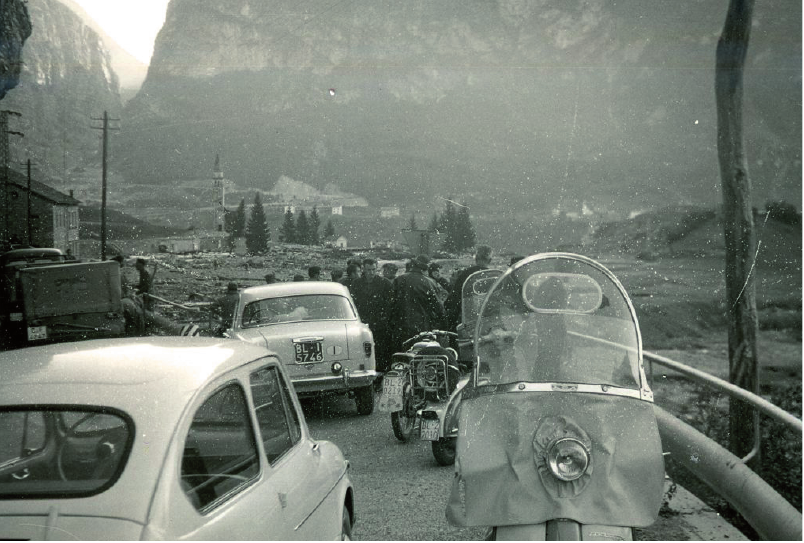
Figure 5. The first dawn light on the Pirago bell tower, the only building in Longarone miraculously left